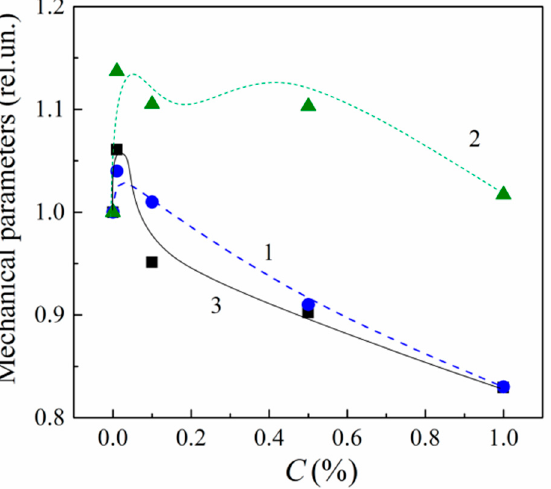
Figure 5. Concentration dependences of compressive strength ( σ 0 , 1), Young’s modulus ( E , 2) and the conformational deformation ( ∆ ε , 3) for MLG–epoxy